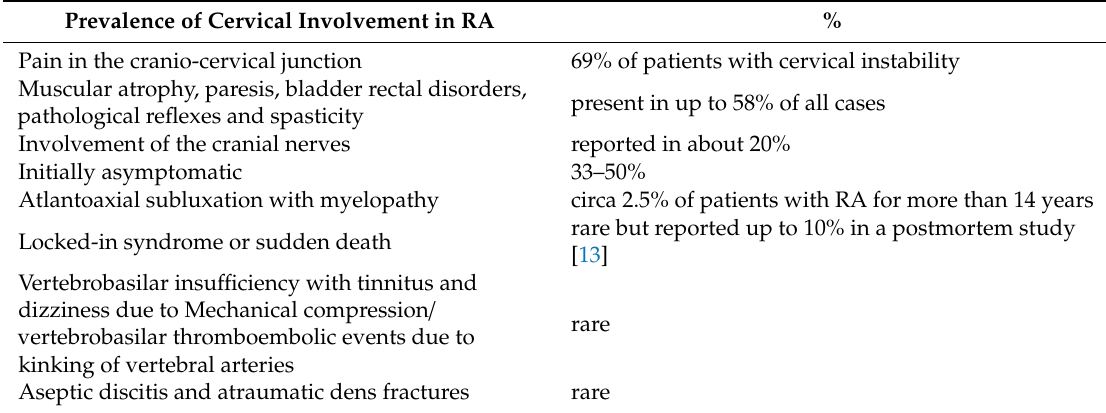
Figure 2. Various diagnostic criteria of cranial settling. Chamberlaine: Line from the dorsal end of the hard palate to the posterior border of the foramen magnum. If the dens is 3 mm above the line, a basilar invagination is present by definition ( A ). McGregor: Line from the hard palate to the deepest point of the occiput. A basilar invagination is present if the tip of the dens is more than 4.5 mm above the line ( A ). Clark-Station: Here the dens is divided into three equally sized stations. If the front arch of the atlas reaches into station II or III the criteria of a cranial settling is fulfilled ( B ). Redlund-Johnell: describes the distance between the center of the lower cover plate C2 and the McGregor line. Normal is 34 mm for men and 29 mm for women ( C ). Table 2. Prevalence and symptoms of pat with clinical involvement